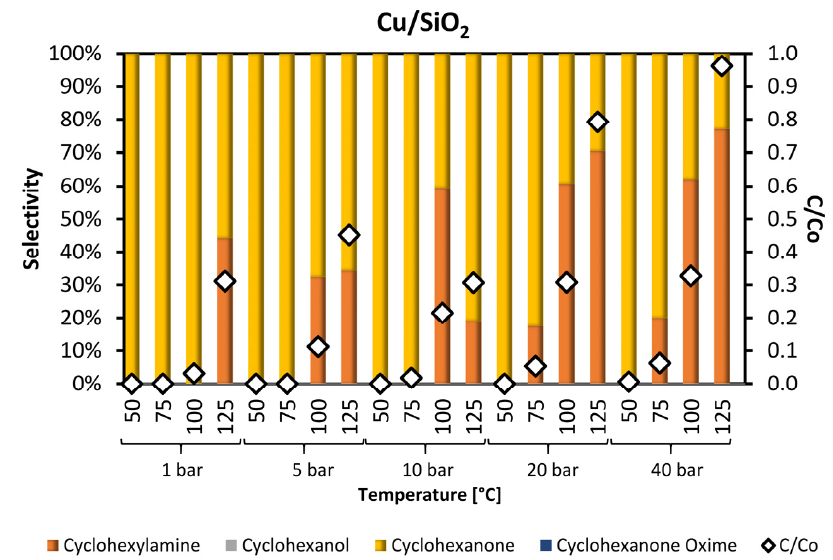
Figure 7. Catalytic hydrogenation of nitrocyclohexane in liquid flow conditions with Cu/SiO 2 .